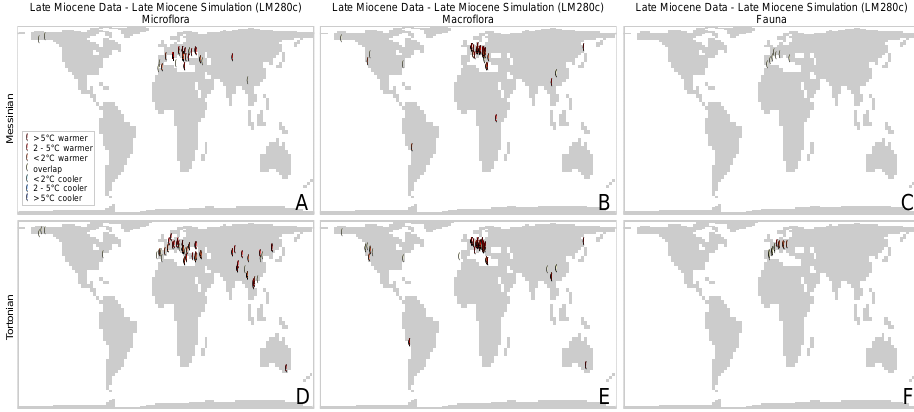
Fig. 8. Results from the model–data comparison for mean annual temperature, late Miocene data–LM280c.